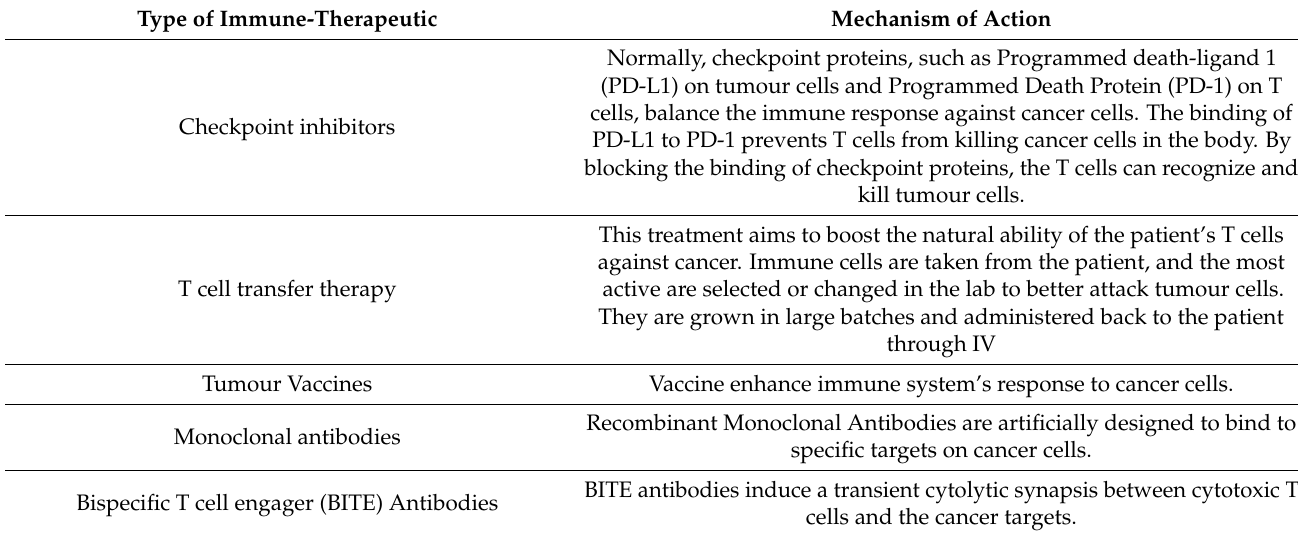
Table 2. Immunotherapies strategies and mechanism of